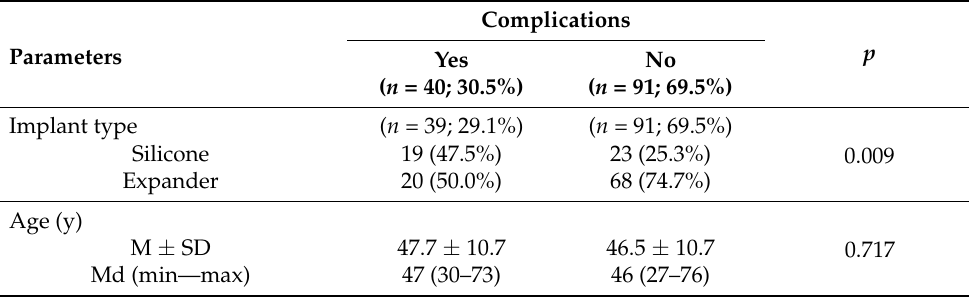
Table A1. Statistical results; M = mean, Md = median, SD = standard deviation.